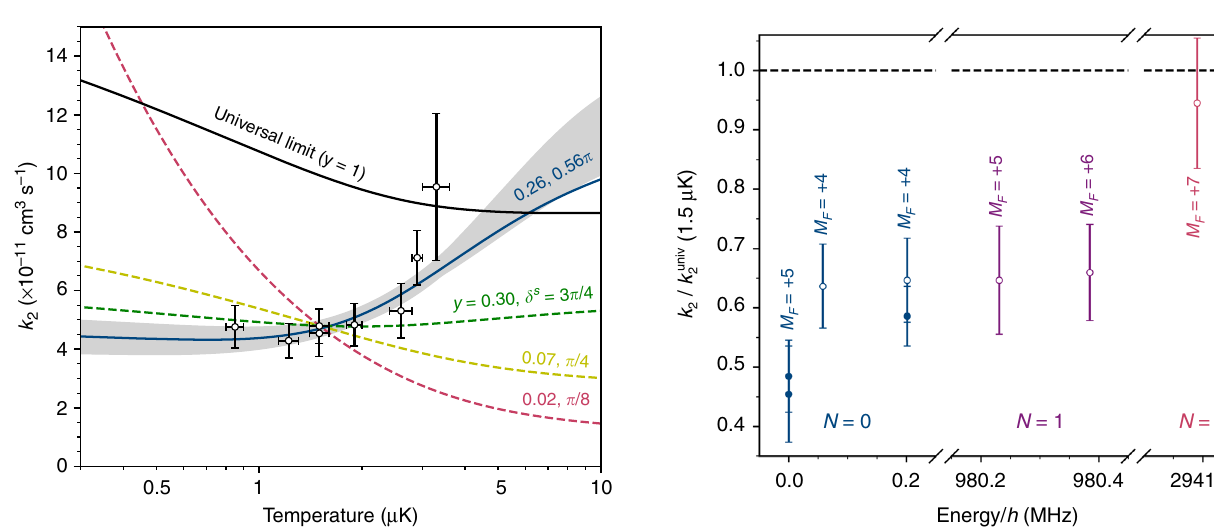
Fig. 3 Temperature dependence of the loss rate coef fi cient. The horizontal and vertical error bars show the 1 σ uncertainties in the measured temperature and loss rate coef fi cient k 2 , respectively. The coloured dashed lines all match the experimental rate coef fi cient at T = 1.5 μ K, for a range of values labelled by y , δ s that follow the solid black line in Fig. 2. The solid blue line shows the best fi t, and the shaded region corresponds to the range of parameters that agree with the experimental results (open circles). The black line shows the loss rate in the universal limit ( y = 1) ¼ 0 : 473), and the fi tted loss rate is shown as the blue line in ( χ 2 red Fig. 3 with uncertainty given by the shaded region. This gives us our fi rst indication of the scattering length for RbCs + RbCs collisions; the fi tted δ s corresponds to 231 a 0 < a < 319 a 0 .